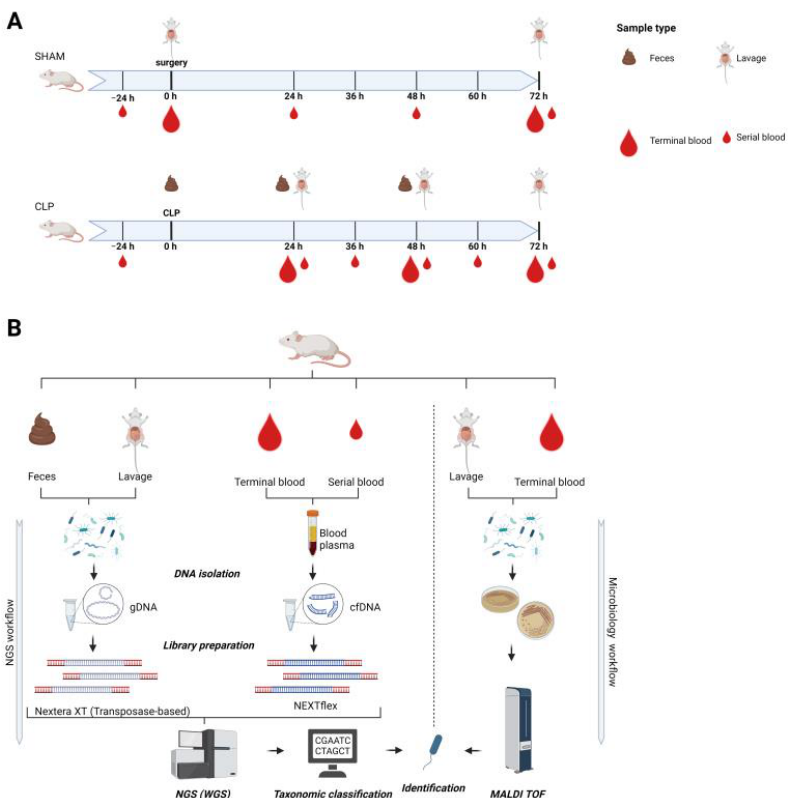
Figure 1. Schematic illustration of the study design ( A ) and of the analytical workflow ( B ). ( A ): Three-month-old female mice ( n = 45) were subjected to polymicrobial cecal ligation and puncture (CLP) sepsis (lower axis) or served as sham controls (upper axis) and were sampled in defined intervals for blood, feces, and abdominal lavage until 72 h post-CLP. Small blood drop indicates a serial small-volume sampling; large blood drop indicates terminal blood sampling. Short-interval serial blood sampling was performed maximally three times per individual mouse (i.e., serial blood sampling time points varied among mice to cover intervals smaller than 24 h) followed by terminal large-volume sampling. In each mouse, feces were collected at CLP and at the sacrifice time point. In each mouse, abdominal lavage was performed at the sacrifice time point. Body weight and temperature were taken daily. ( B ): NGS workflow was performed for all sample types. DNA was isolated, and all libraries were used for whole genome shotgun sequencing; nonmurine reads were classified and used for identification of species. Abdominal lavage and terminal blood were used for microbiological culturing in parallel. Growing cultures were used for species identification by means of MALDI